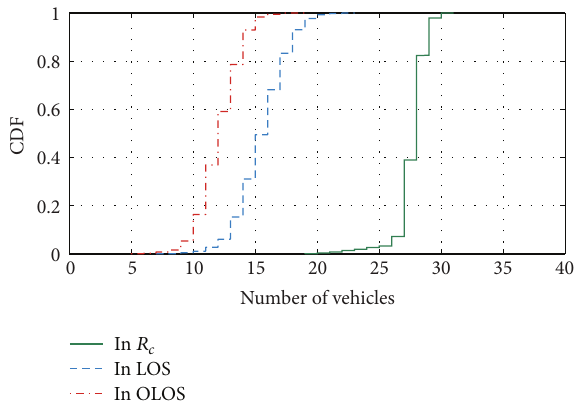
Figure5:CDFsofthetotalnumberofvehiclesin 𝑅 𝑐 andthenumber of vehicles in LOS and OLOS state at each time instant for total simulation time 𝑇 = 120